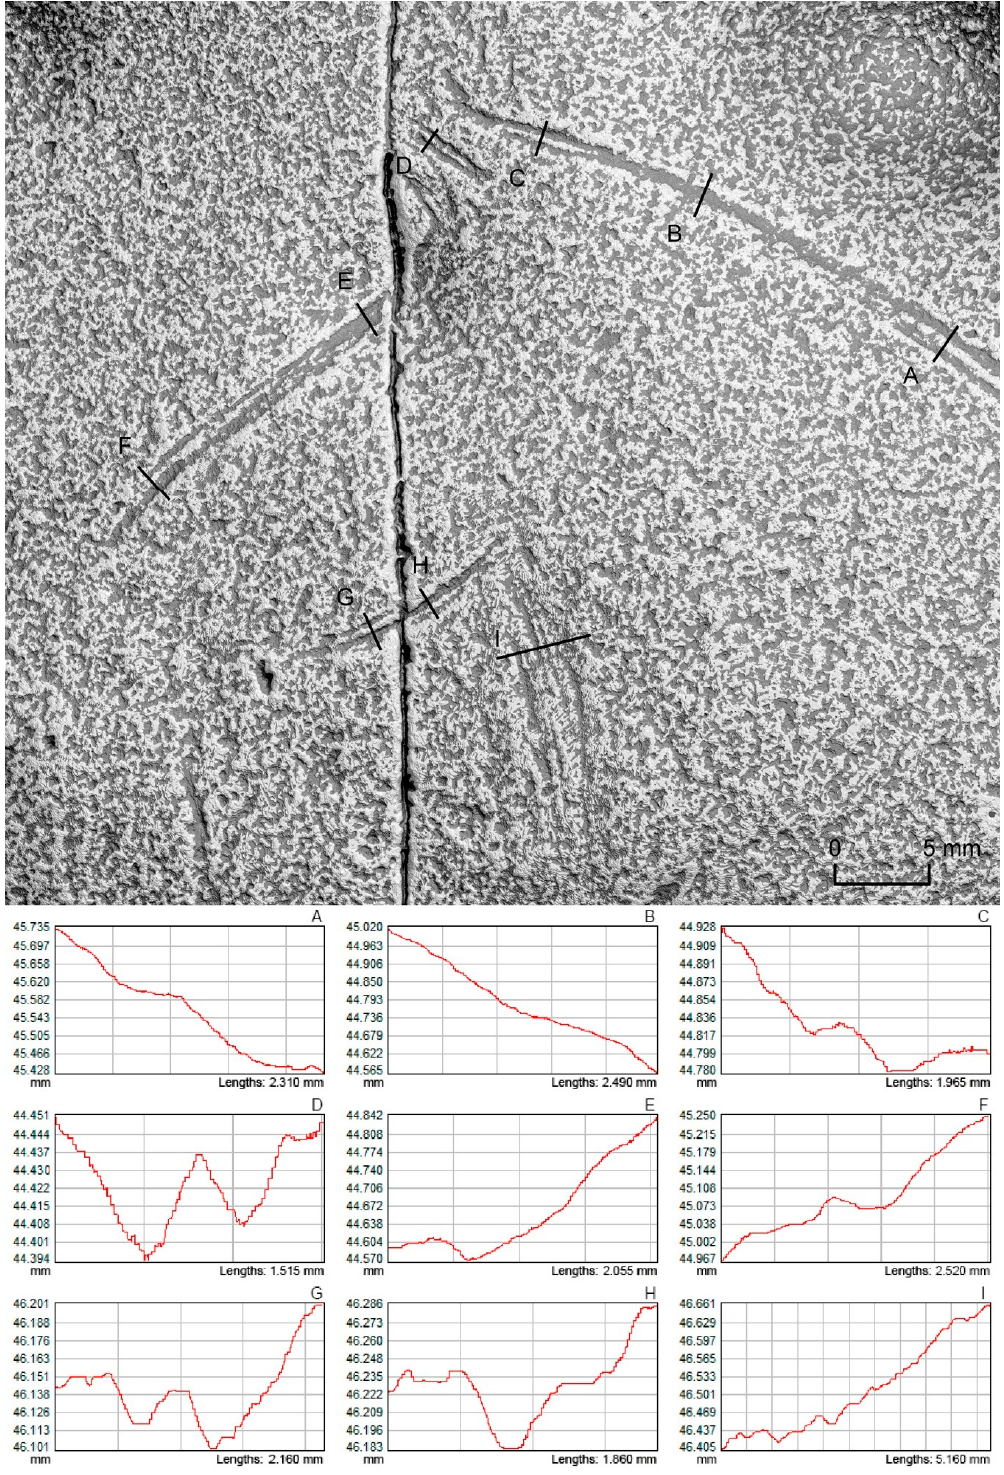
Figure 8. Head detail resulting from superimposing the hillshade layer with a transparency of 35% on the high pass layer. Nine outlines of the lines are shown on the horsehair ( A – C ), ears ( D ), forehead ( E ), snout ( F ), jaw ( G , H ), and neck ( I ).